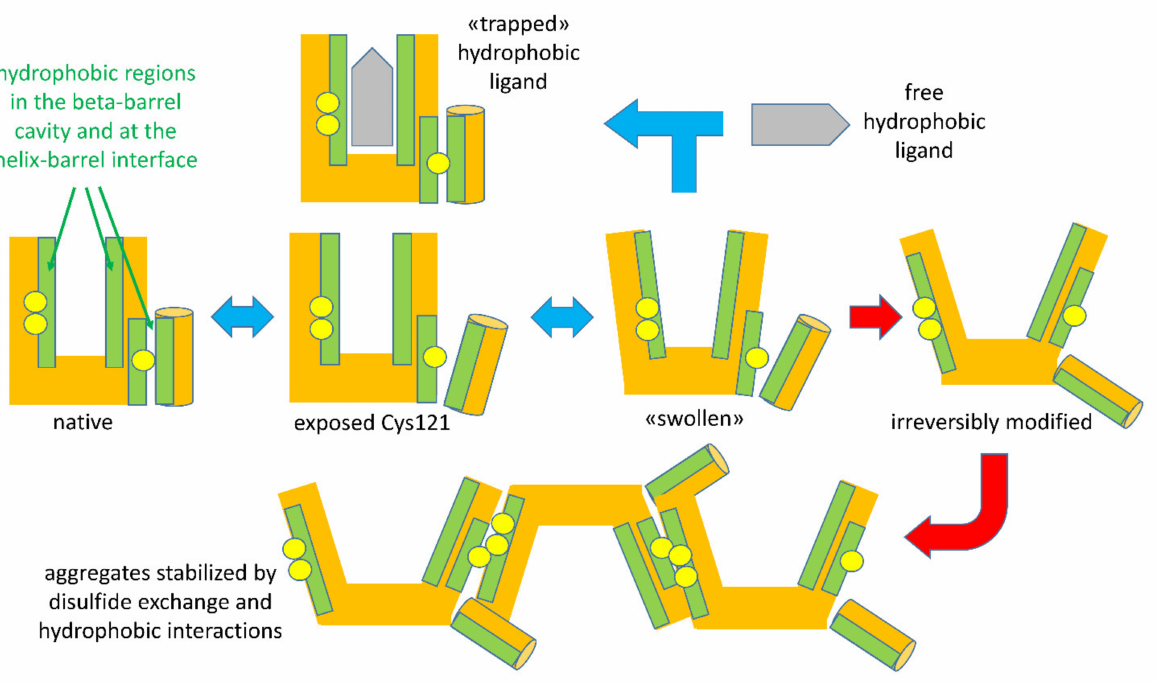
Figure 3. A schematic of the temperature-dependent denaturation events relevant to binding or entrapment and to formation of BLG aggregates. Reversible steps are indicated by blue double-ended arrows. Red arrows indicate irreversible steps occurring above a given temperature threshold (about 60 ◦ C for ligand-free